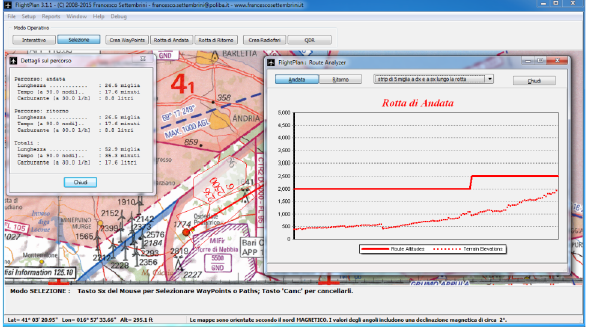
Figure 10. Flight Planning in FlightPlan